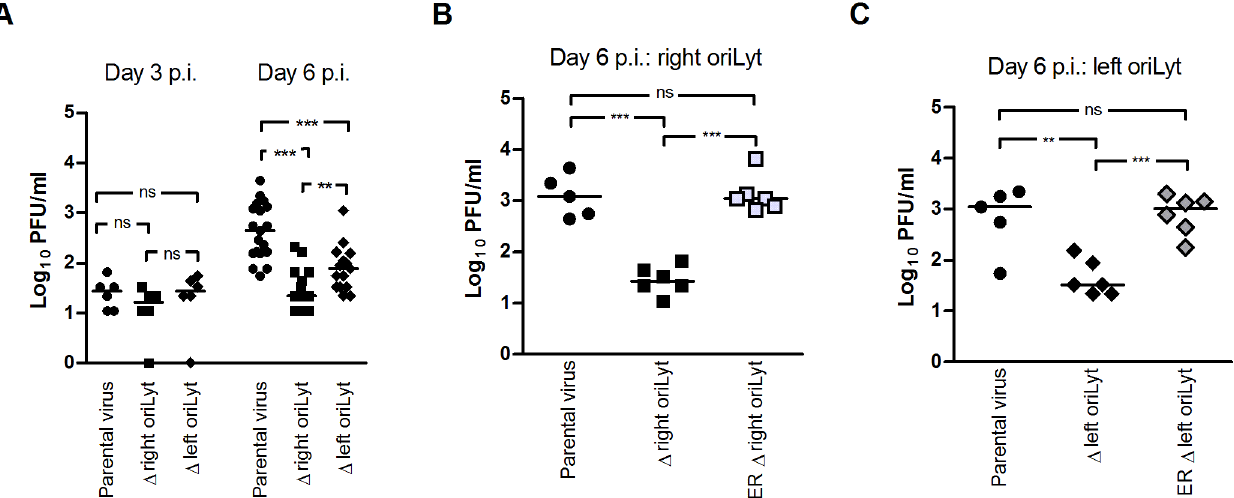
Fig 2. Lytic replication in the lungs after i.n. inoculation. C57BL/6 mice were inoculated i.n. with 1x 10 3 PFU of the indicated viruses. Lungs of mice were harvested at day 3 after infection (parental virus or mutant viruses) and at day 6 after infection (parental or mutant viruses and ectopic revertants). Virus titers were determined from organ homogenates by plaque assay. Each symbol represents an individual mouse, and the bars represent the median value. (A) The data are compiled from two (day 3) and five (day 6 mutant viruses) or six (day 6 parental virus) independent experiments. (B and C) The data are compiled from two independent experiments in each case. The asterisks indicate a statistically significant difference between the groups ( * P < 0.05; ** P < 0.01; *** P < 0.001).